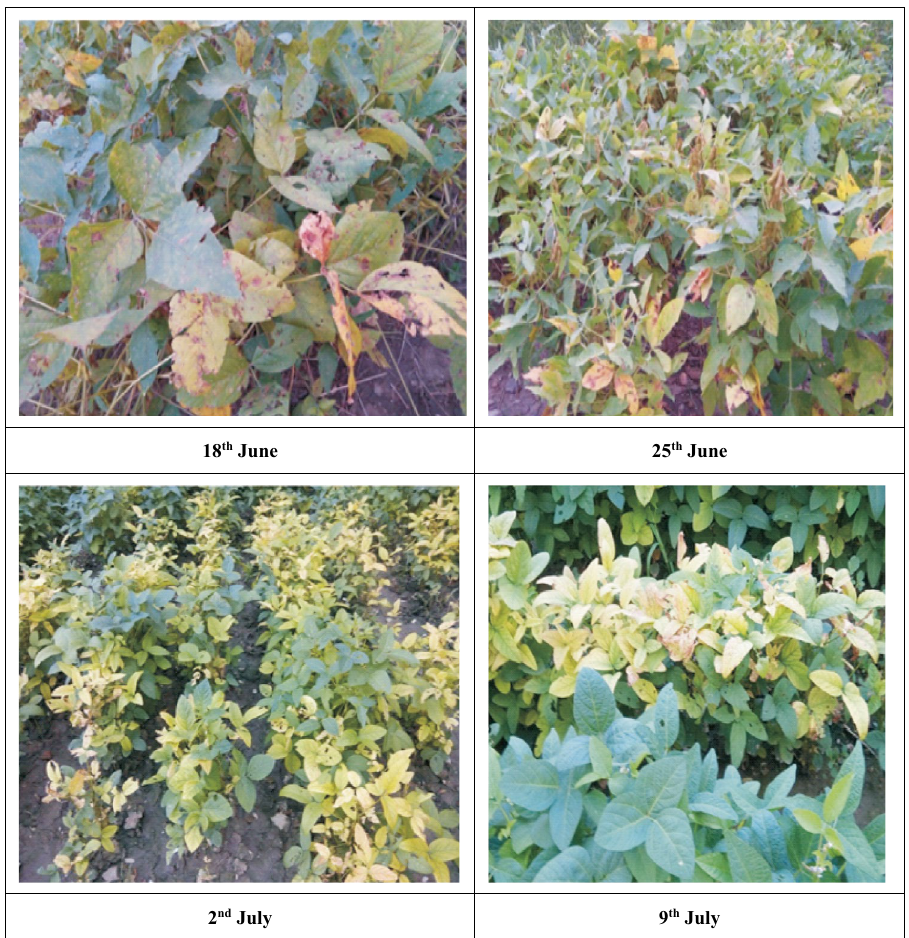
Figure 4. Effect of different date of sowing on development of Alternaria leaf spot soybean in field